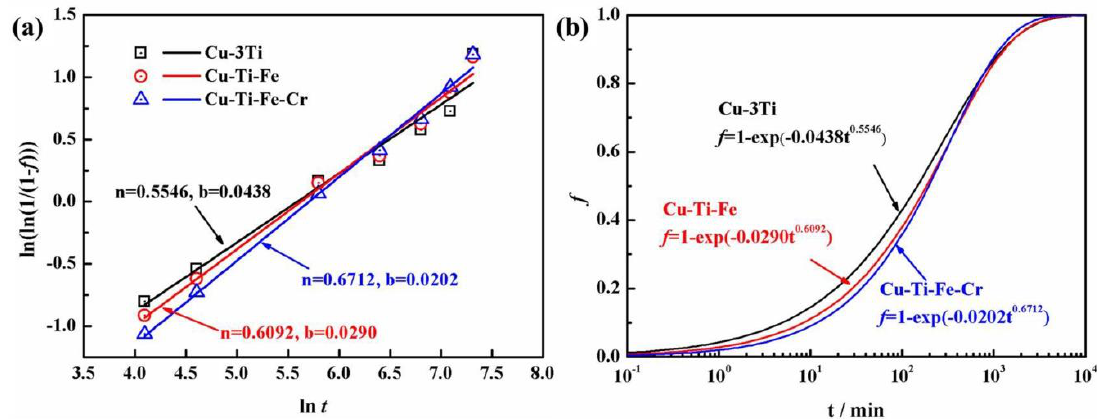
Figure 5. Relation between the volume fraction and the transformation time aging, at 450 °C. ( a ) Fitting data; ( b ) kinetic curves of the phase transformation.